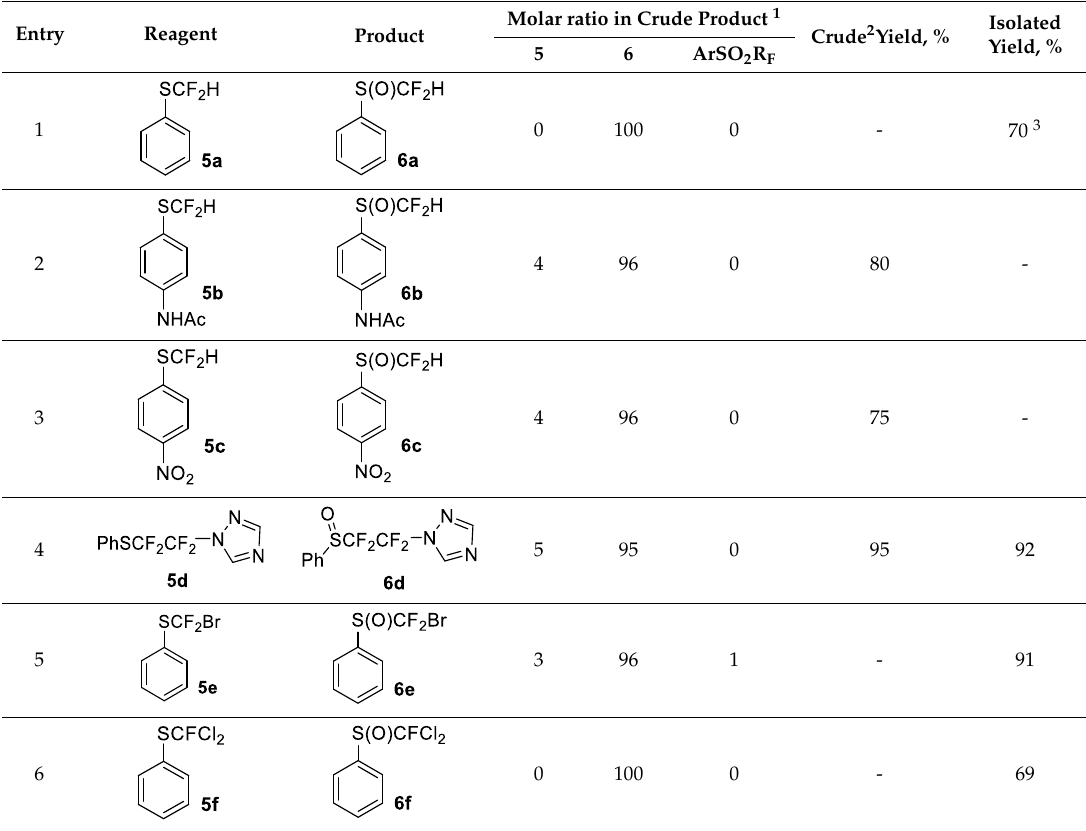
Table 3. Oxidation of fluoromethyl and difluoromethyl sulfides 5 .